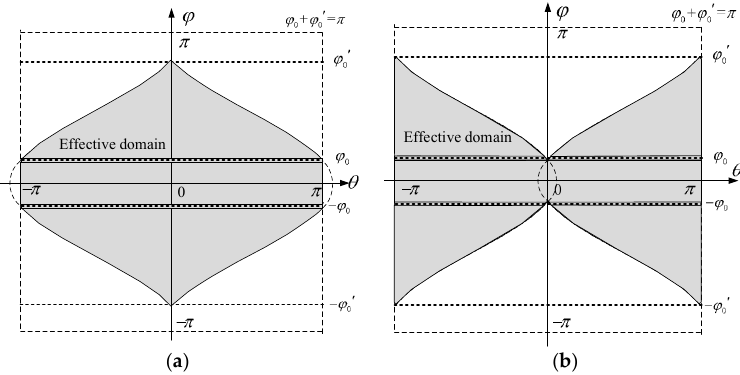
Figure 6. Effective domain of integration. ( a ) Effective domain (Initial angle of carrier α = 0). ( b ) Effective domain (Initial angle of carrier α = π ).